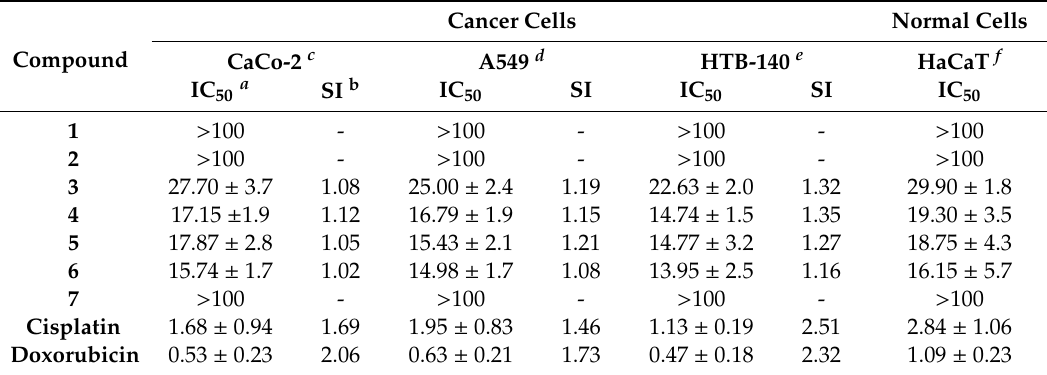
Table 3. Cytotoxic activity of tested compounds estimated by the MTT